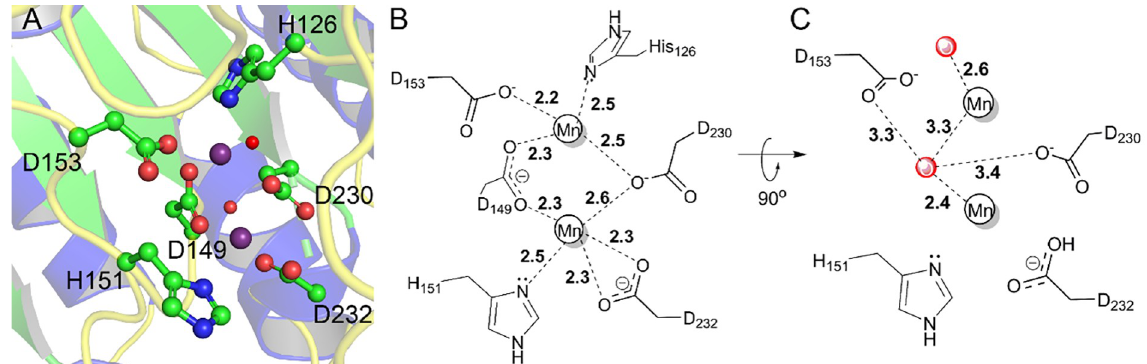
Fig 5. Metal binding in the SPEB active site. Two clear peaks of electron density were observed in the structure and were modeled as Mn 2+ ions (A, represented as purple spheres). Also shown are well-defined water molecules that may play a role in catalysis (represented as red spheres). A schematic (B) shows the coordination of the metal ions by active site residues, and the corresponding bond distances. The relative positions, and distances, of the water molecules (red spheres) is similarly depicted in a schematic (C) of the same site that was rotated 90˚, relative to B, as